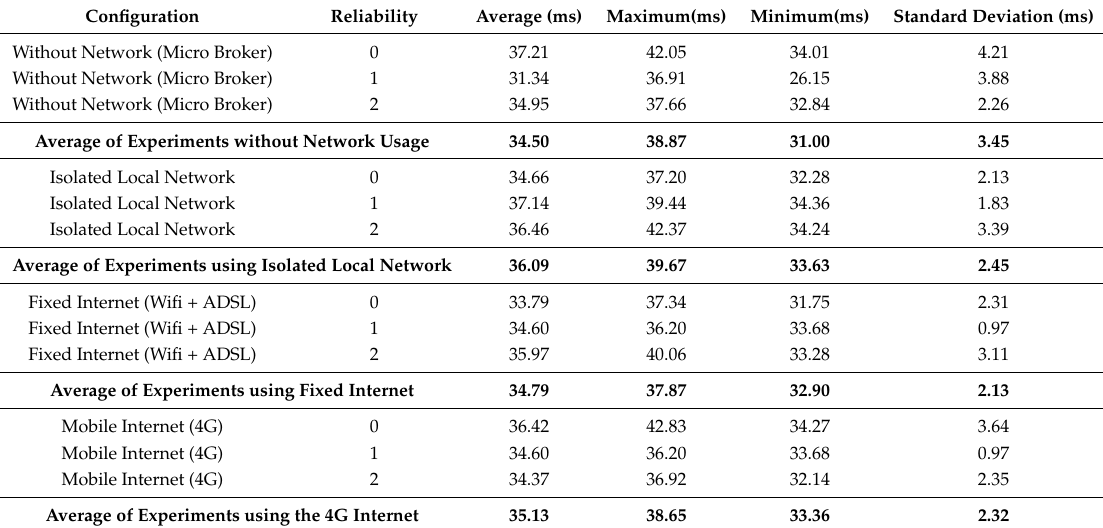
Table 3. Evaluation of the Distribution Service Performance in relation to the Processing Time.